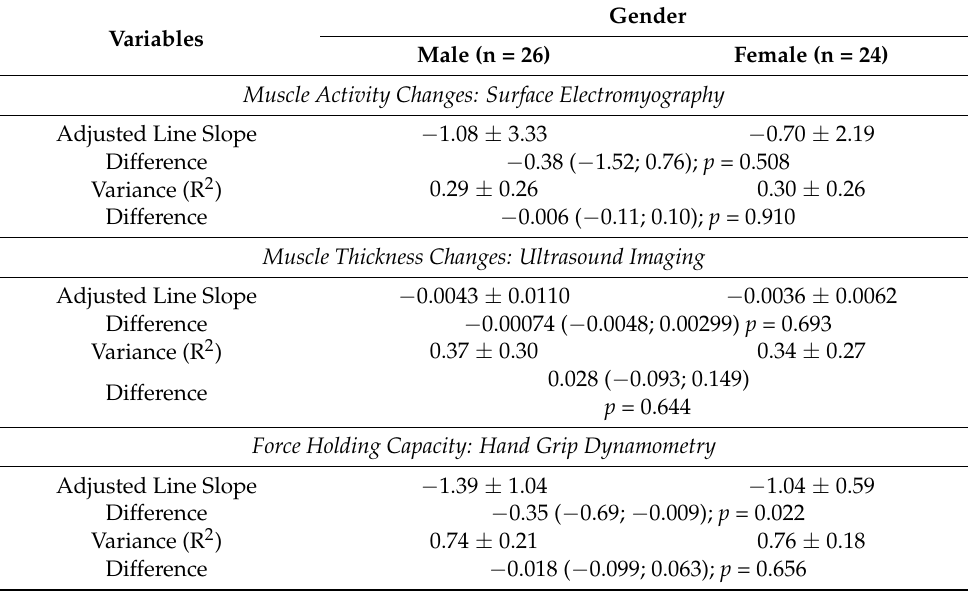
Table 3. Fatigue assessments with EMG, US and dynamometry by gender.